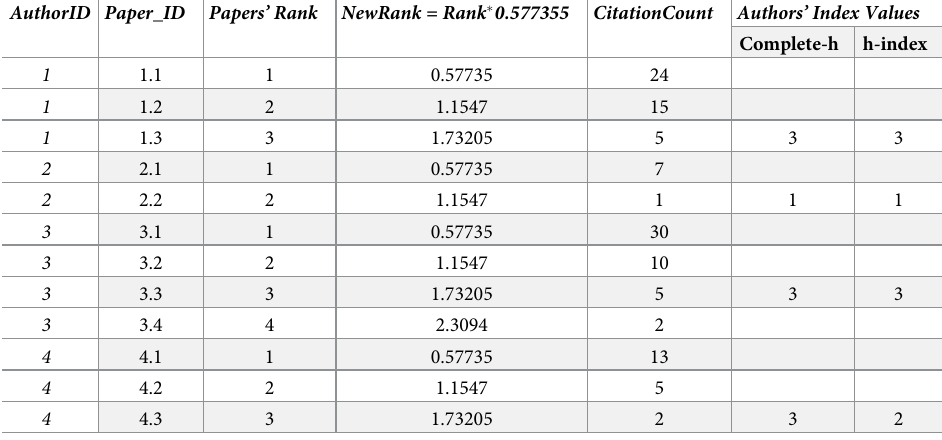
Table 4. Complete-h and h-index calculated for example